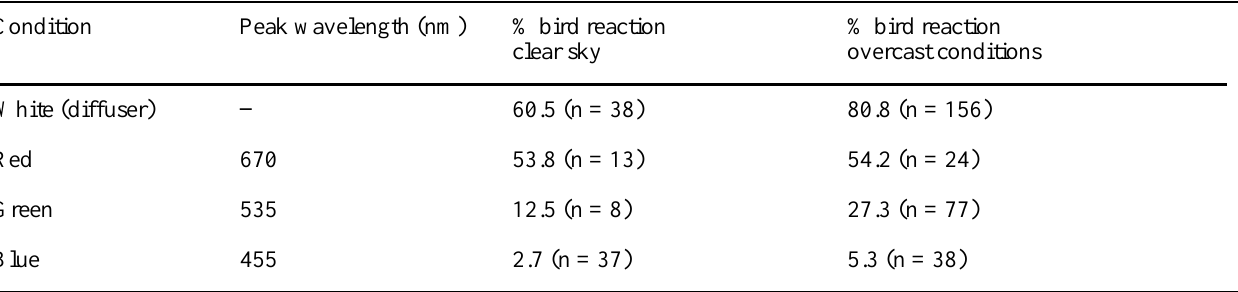
Table 3. Reaction of nocturnally migrating birds to different light conditions (peak wavelength indicated) under clear and overcast skies. It was noted that the red part of the spectrum is best characterized by a shoulder between 590–680 nm. The number of observations is given in parentheses, where groups are counted as a single